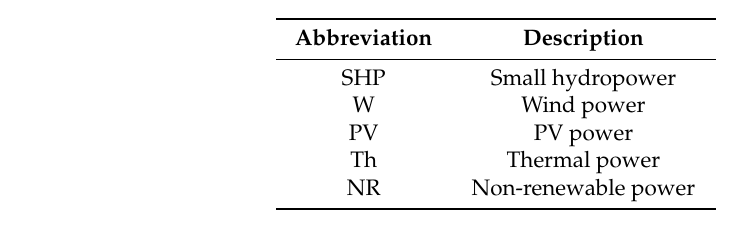
Table A2. Abbreviations of the model of the multi-energy integration.